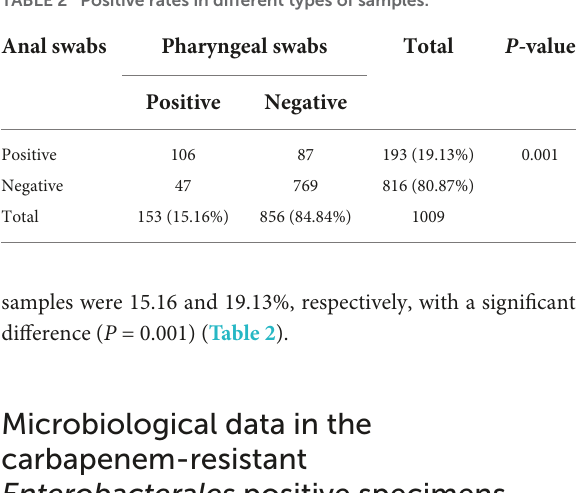
TABLE 2 Positive rates in different types of